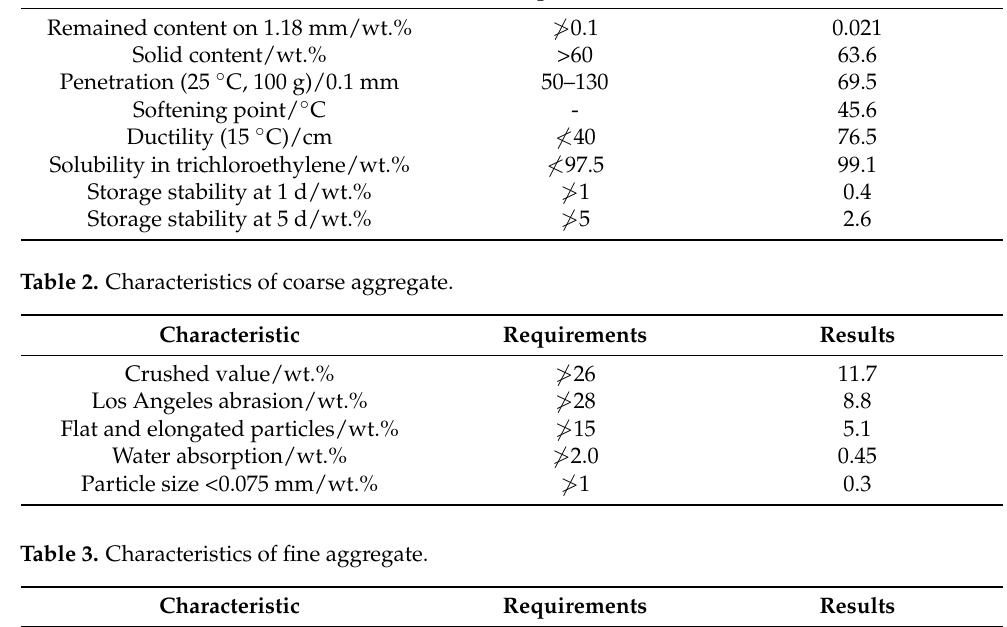
Table 1. Characteristics of asphalt emulsion. Characteristic Requirements Results Remained content on 1.18 mm/wt.%